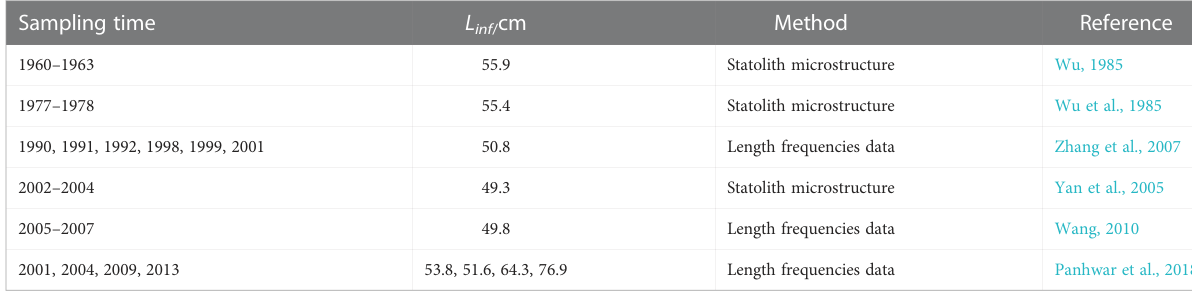
TABLE 3 L inf of T. lepturus in the East China Sea in different periods. Sampling